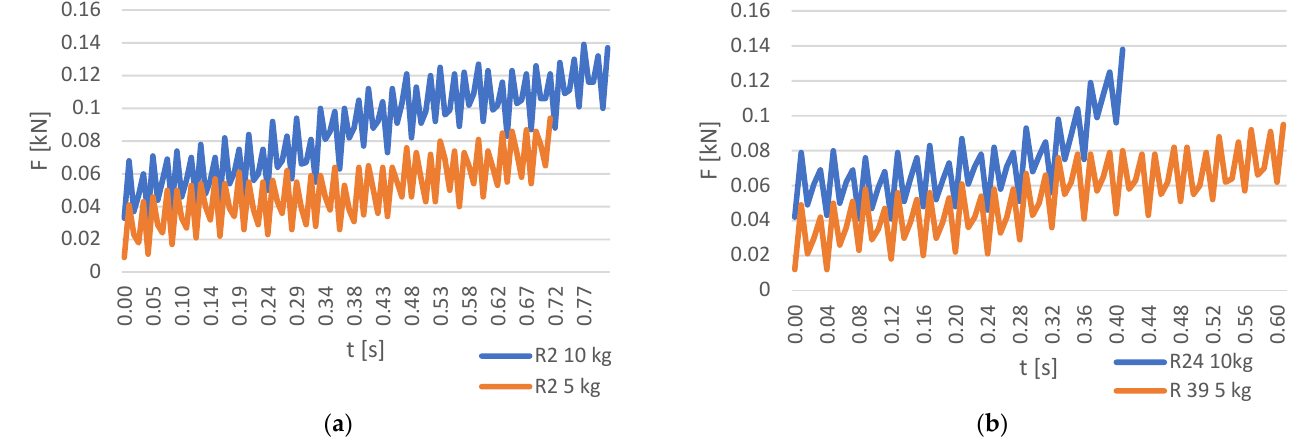
Figure 9. Comparison of initial repetition ( a ) and final repetition ( b ) for 10 kg and 5 kg, respectively.